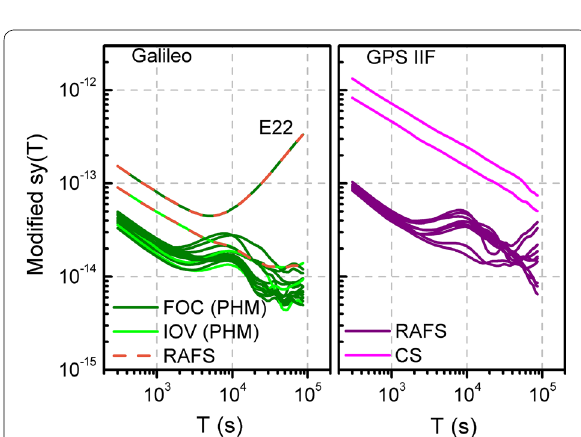
Fig. 8 Median ADEVs of Galileo ( left ) and GPS IIF ( right )